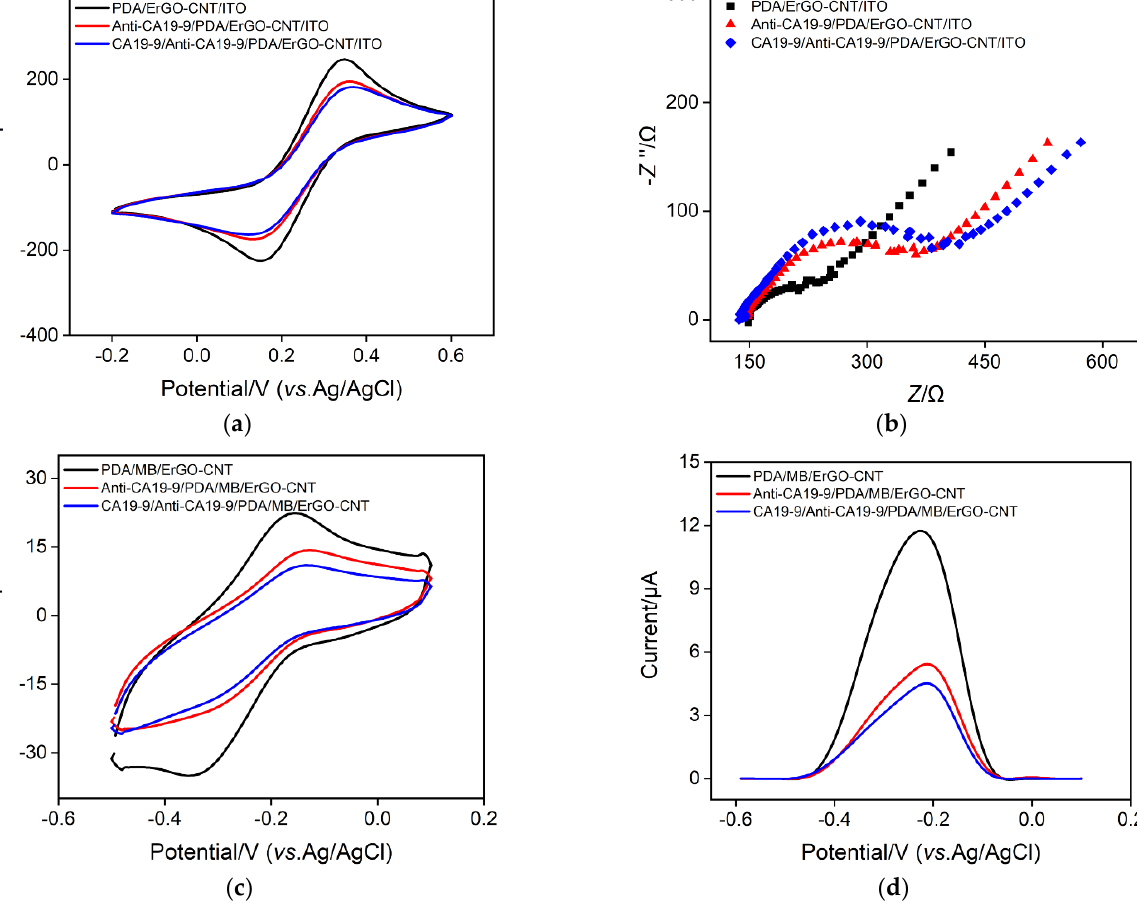
Figure 7. ( a ) CV and ( b ) EIS plots of different electrodes in 0.1 M KCl solution containing 2.5 mM Fe(CN) 63 – /4 – . ( c ) CV and ( d ) DPV curves of different electrodes in 0.01 M PBS (pH = 7.4).